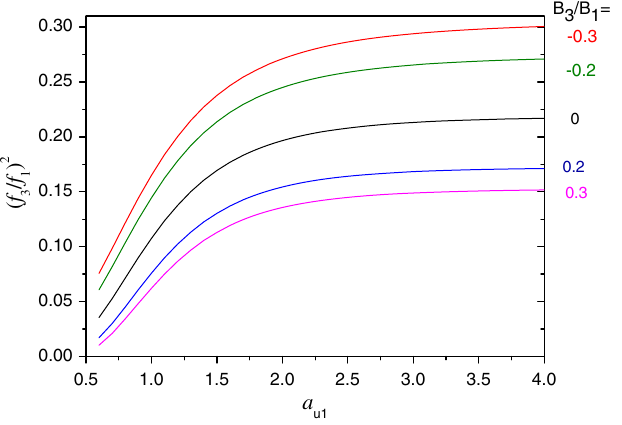
FIG. 3. The effect of B 3 on FEL harmonic generation.